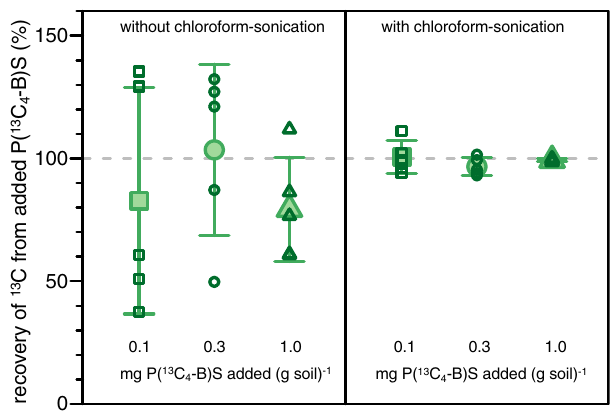
Fig. 2 | Effect of soil treatment on quanti fi ed amounts of non-mineralized poly(butylene succinate) (PBS) remaining in soil. Recovery of butanediol- 13 C-labelled PBS (i.e., P( 13 C 4 -B)S) from soils containing known added amounts (i.e., 0.1 (squares), 0.3 (circles), and 1.0 (triangles) mg P( 13 C 4 -B)S per g soil) without (left) and with (right) chloroform-sonication treating the soils prior to EA-IRMS on small soil aliquots of 10mg. Recoveries are expressed as amount of 13 C quanti fi ed in percent of the expected 13 C amount if added PBS particles were representatively sampled in the small soil aliquots for EA-IRMS. The open symbols depict recoveries of fi ve individually analyzed replicates per soil, and closed symbols and corresponding error bars depict the average and standard deviations of the fi ve replicates, respectively. Recovery of PBS-derived 13 C was inaccurate and imprecise when we analyzed aliquots taken from soils that were only sieved and milled (left side). Conversely, recovery was complete, accurate and precise when analyzing subsamples from sieved and milled soils that were additionally treated by chloroform-sonication (right